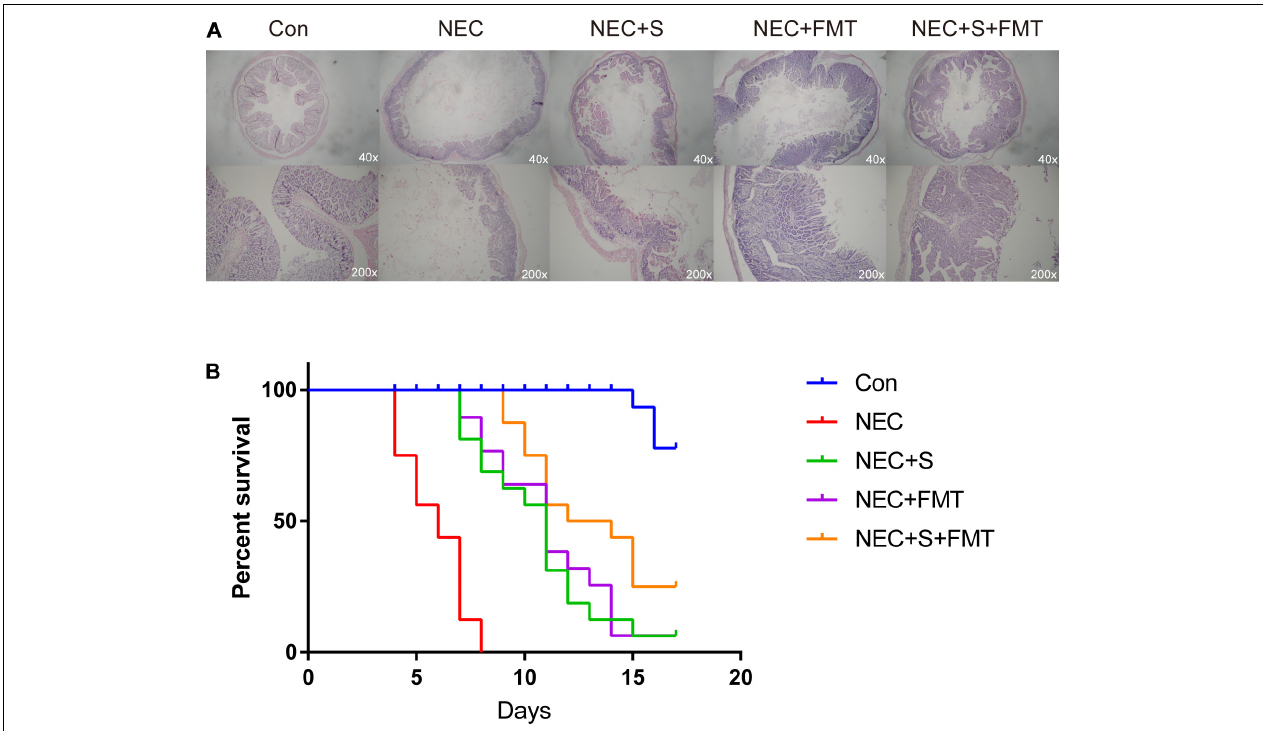
FIGURE 1 | Fecal microbiota transplantation (FMT) and sulperazone combination treatment efficiently antagonizes necrotizing enterocolitis (NEC). (A) Pathology pictures and (B) survival analysis of different groups. Con, control; NEC, necrotizing enterocolitis; S, sulperazone; FMT, fecal microbiota transplantation.